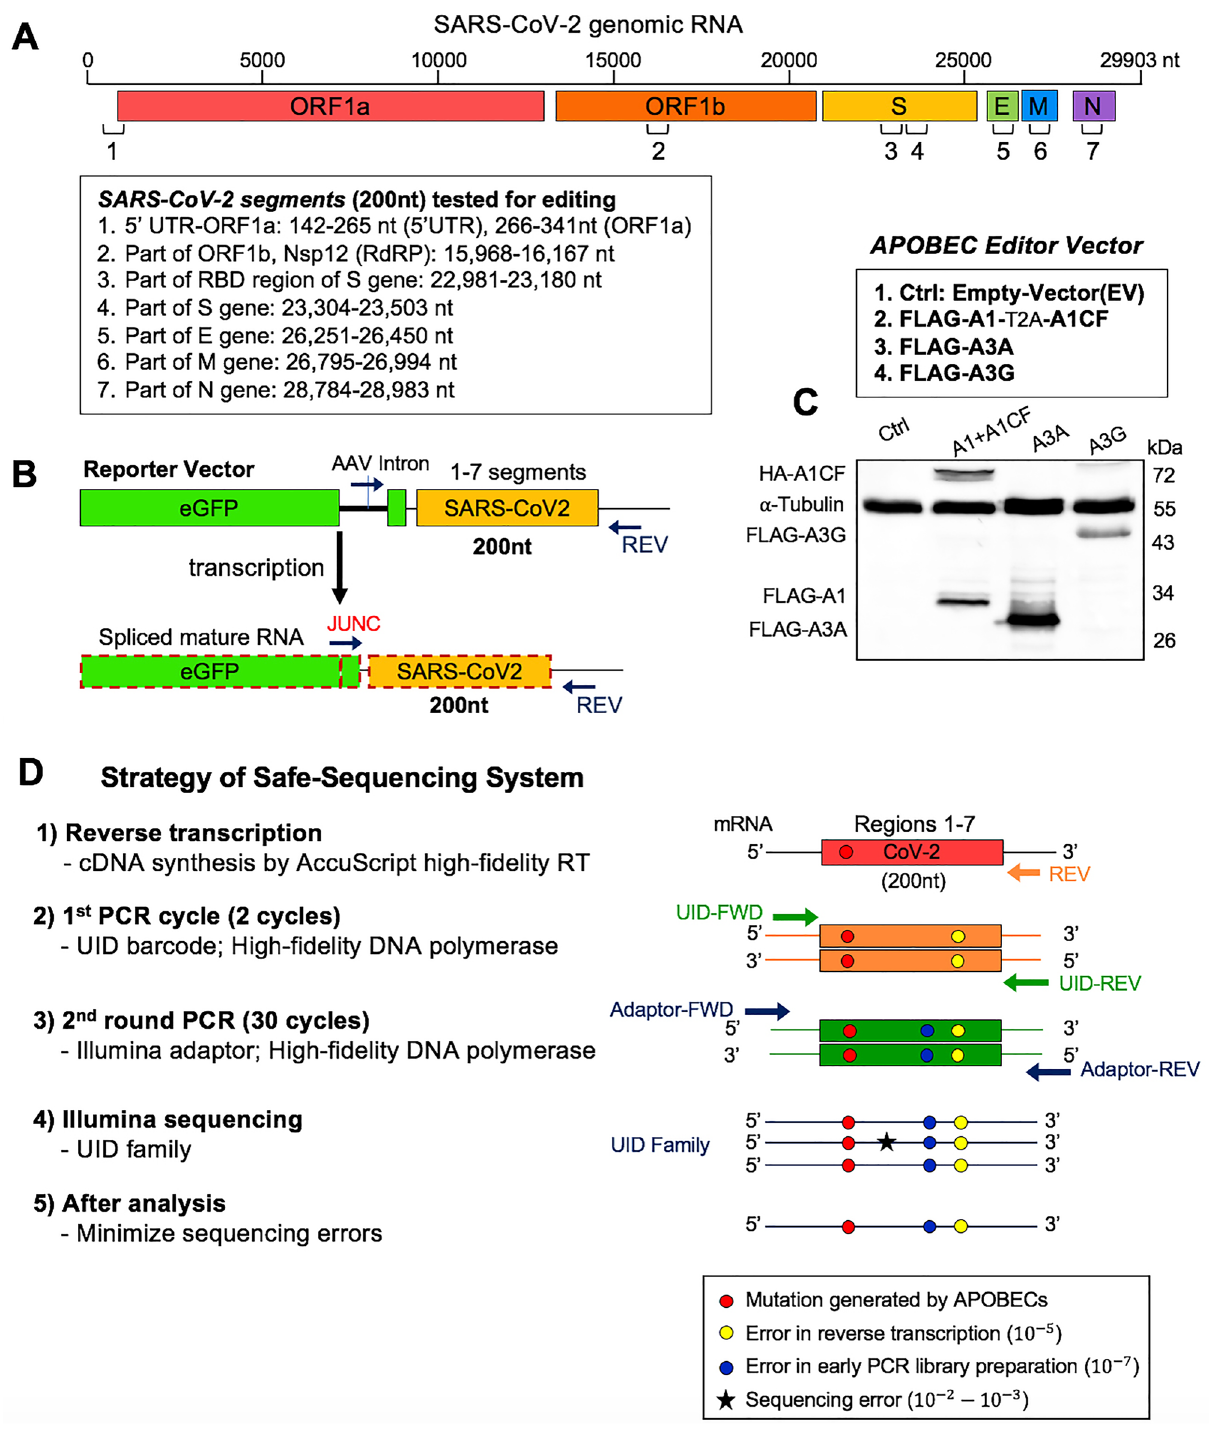
Figure 1. APOBEC-mediated editing test of SARS-CoV-2 RNA. ( A ) Diagram of the SARS-CoV-2 genomic RNA, showing the positions (box) of the seven RNA segments (1–7) selected for studying the RNA editing by APOBECs. ( B ) Reporter vector (top) that contain each of the seven selected viral RNA segments that are transcribed into an RNA containing an AAV intron between the eGFP and the viral RNA segment. Splicing out the AAV intron yields a mature mRNA with a new spliced junction sequence (JUNC) that differs from its coding DNA, which can be used to selectively amplify either the mature mRNA or the coding DNA. ( C ) Three APOBEC editor vectors (top, A1-2A-A1CF, A3A, and A3G) and the Western blot showing their expression in 293 T cells (bottom). A1-2A-A1CF is constructed as one open reading frame (ORF) with a self-cleavage peptide T2A inserted between A1 and A1CF, which produced individual A1 and A1CF proteins in a 1:1 ratio 28,58 . ( D ) Strategy of the Safe-Sequencing-System (SSS) to minimize errors from PCR amplification and sequencing. After the SARS-CoV-2 RNAs from cell extracts are reverse transcribed, the cDNAs are sequentially amplified by the UID barcode (2 cycles) and the Illumina adapter (30 cycles). This SSS approach will distinguish the C-to-U mutations caused by APOBECs from the PCR and sequencing errors (see